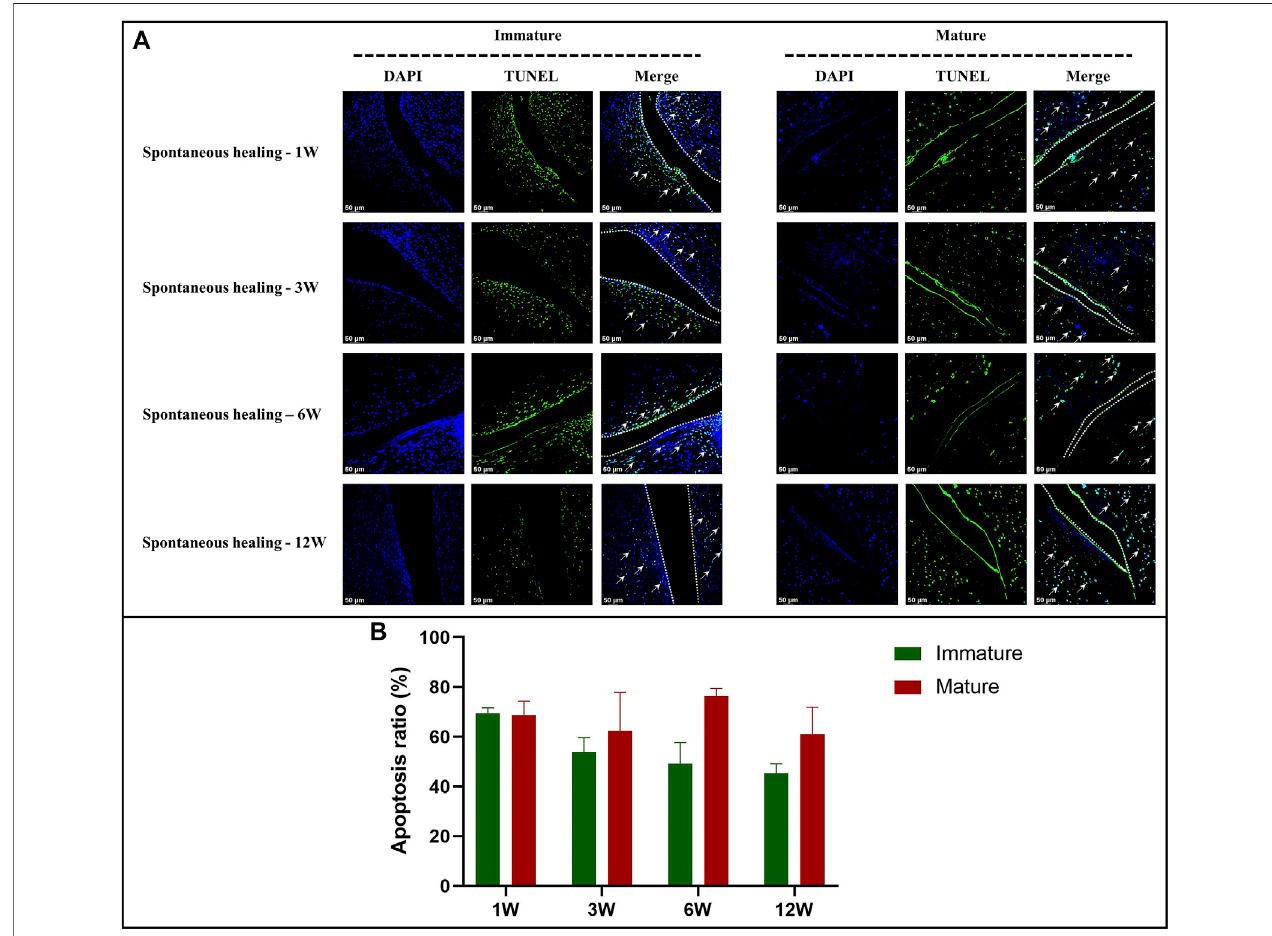
FIGURE4| Theassessmentofapoptosis inimmature andmaturemenisciafter untreated meniscaltears. (A) TUNELstaining. Thewhitearrowsindicateapoptotic cells. The dotted white lines indicate tear edges. (B) Apoptosis ratio. The values are expressed as median values with 95% CIs. n (cid:1) 4.